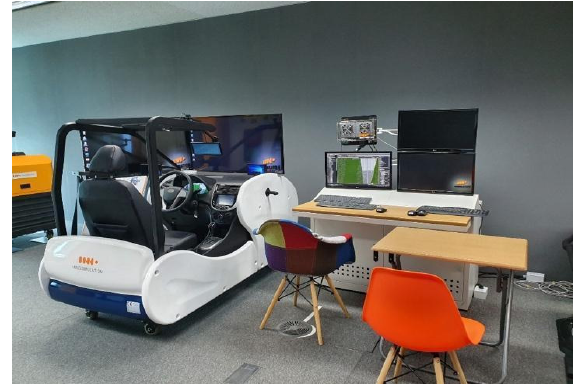
Figure 13. A driving simulator which can simulate various driving environments (Source: Own creation).